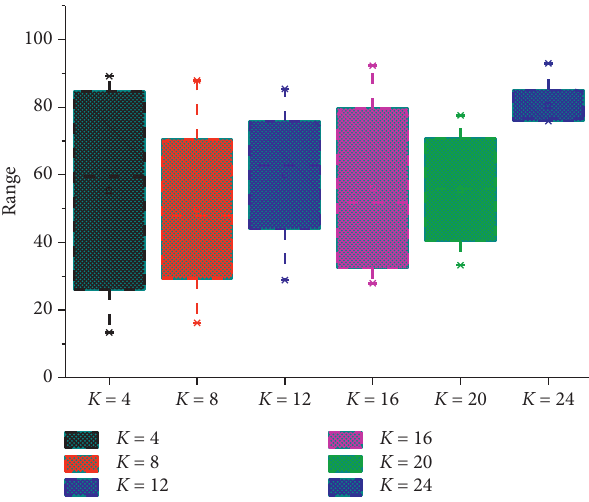
Figure 8: Simulation runtime